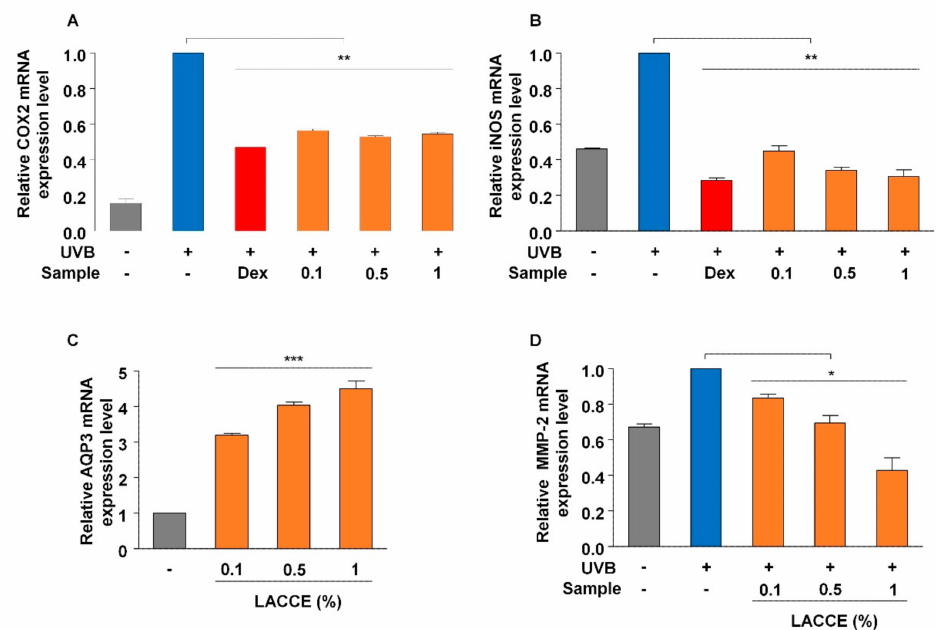
Figure 3. In vitro assessment of LACCE as anti-inflammatory, moisturizing, and anti-wrinkle agents by real-time RT-PCR. Relative expression of COX2 ( A ) and iNOS ( B ), two inflammatory marker genes, in di ff erent LACCE concentrations in response to UVB-treated samples was measured by real-time RT-PCR. Dexamethasone (Dex) was used as a positive control. Gray and blue bars indicate HaCaT cells without and with UVB treatment, respectively. ( C ) Relative expression of AQP3, a positive marker for moisturizing e ff ect, in di ff erent LACCE concentrations. ( D ) Relative expression of MMP-2, a cell growth marker, in di ff erent LACCE concentrations in response to UVB. Expression of individual gene was normalized to GAPDH gene expression. * and ** indicate statistical significance with p -values of less than 0.05 and 0.01,